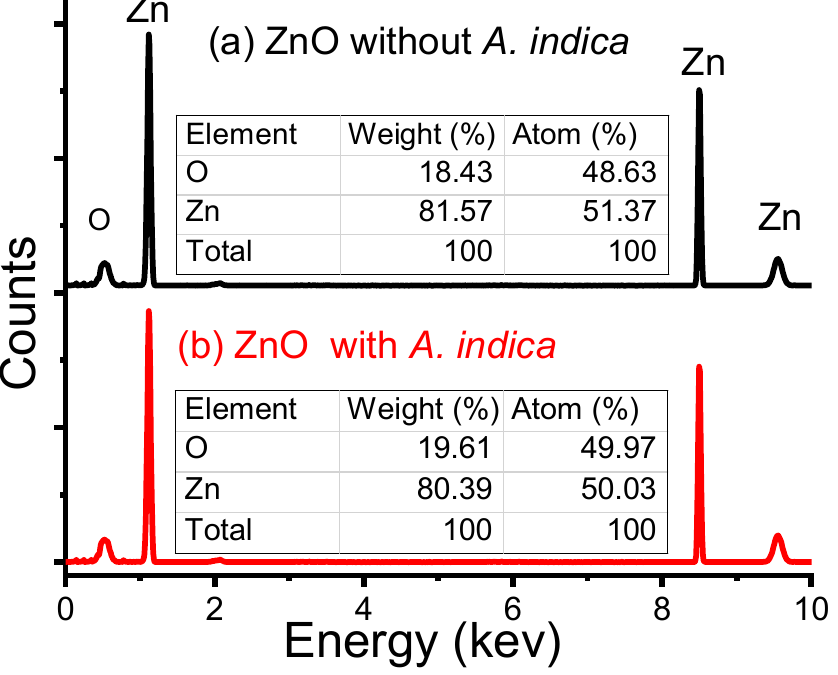
Figure 3. EDX spectra of ZnO NPs ( a ) without A. indica dye extracts and ( b ) with A. indica dye extracts.